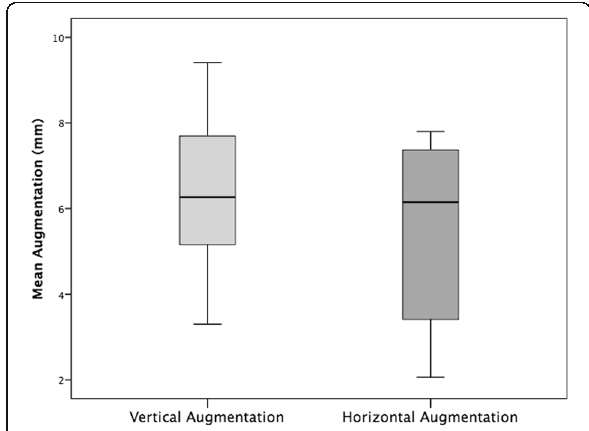
Fig. 10 Mean vertical and horizontal augmentation height